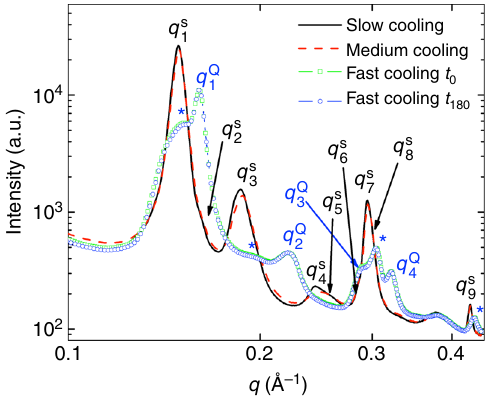
Fig. 5 Small angle X-ray scattering (SAXS) analysis. Intensity vs . wave vector q of compound 1 . Slow cooling: 5 °C min − 1 ; medium cooling: 8 °C min − 1 ; fast cooling: rapid quenching to room temperature from 200 °C. The position of the peaks: q S 1 = 0.1474 Å − 1 , q S 2 = 0.1610 Å − 1 , q S 3 = 0.1907 Å − 1 , Fig. 6 Scanning electron microscopy. SEM images of compound 1 obtained: q a , b on quenching from the isotropic liquid state to room temperature at two different magni fi cations of the same sample and c , d on slow cooling at a rate of 5 °C min − 1 from the isotropic liquid phase to room temperature. Each sample (thickness about 200 μ m) was imaged directly; i.e. no metal was deposited prior to imaging. Additional SEM images can be found in Supplementary Note 11, Supplementary Figure 21 and Supplementary The q dependences of the SAXS signal for the quenched sample Figure 22. Scale bars: 1 μ m are shown right after quenching ( t = 0) and 3 h later ( t = 180 min). Both the fresh ( t = 0) and relaxed ( t = 3 h) quenched samples look q Q i ( Q stands for “ Quenched ” ) different from that of the slow- − 1 to the left of cooled sample. The shoulder at lower q (at 0.193 Å q Q 1 = 0.1609 Å − 1 and marked with a blue *) is overlapping with − 1 − 1 q S 1 , and q Q 3 = 0.2907 Å , q Q 4 = 2 q Q 1 = 0.3211 Å are also over-